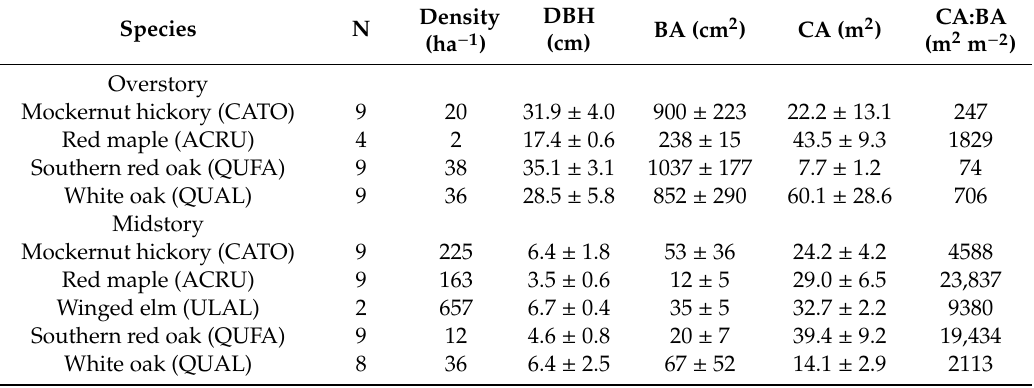
Table 1. Overstory and midstory species (abbreviations given in parentheses) selected for study with